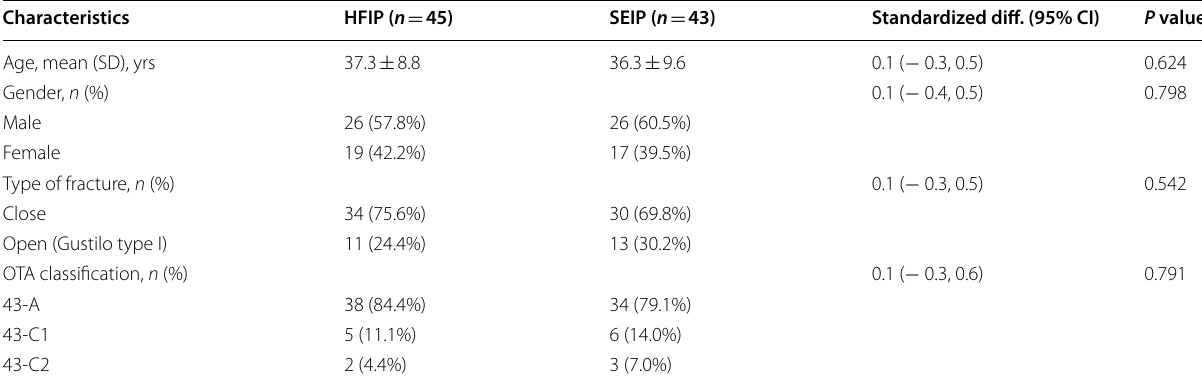
Table 1 Patient baseline